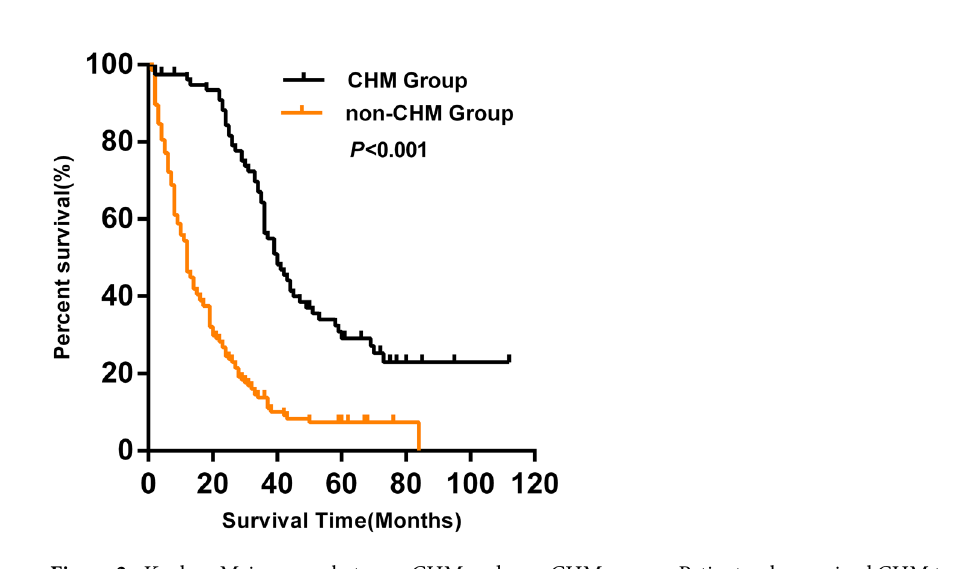
Figure 2. Kaplan–Meier curve between CHM and non-CHM groups. Patients who received CHM treatment had a longer median survival time than those without CHM treatment (40 vs . 12 months, P < 0.001). CHM , Chinese herbal medicine.